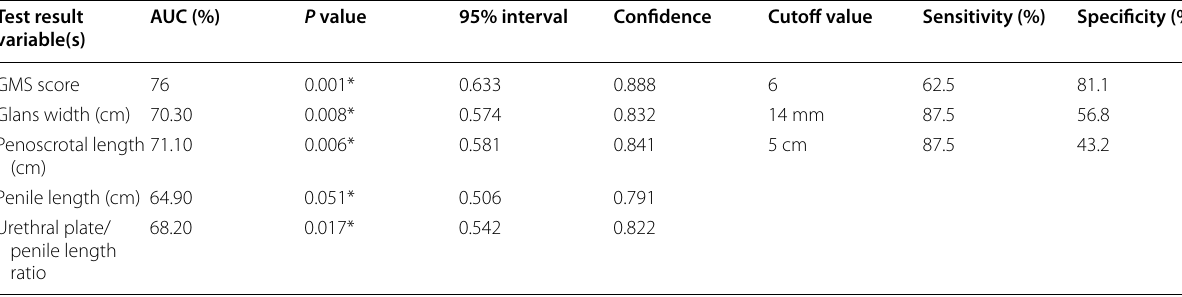
Table 6 (AUC) Area under the ROC curve for GMS score and penile parameters Test result variable(s) Glans width (cm) 70.30 Penoscrotal length (cm) Penile length (cm) 64.90 Urethral plate/ penile